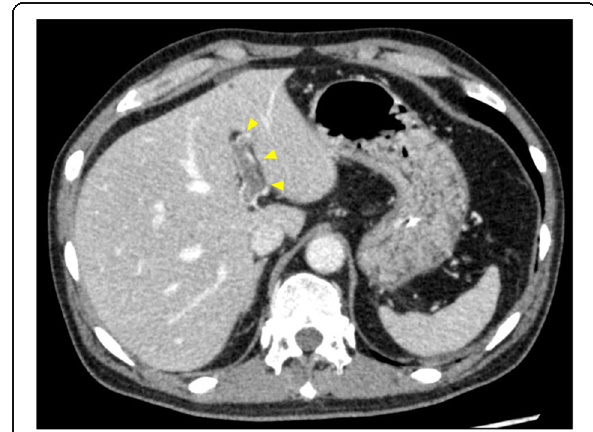
Fig. 4 Postoperative CECT done at day 13 showed portal vein thrombosis (yellow